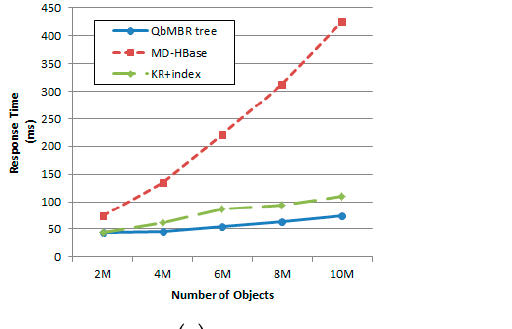
Figure 11. Effect of database size on response time: ( a ) Synthetic dataset with uniform distribution; ( b ) Synthetic dataset with normal distribution.